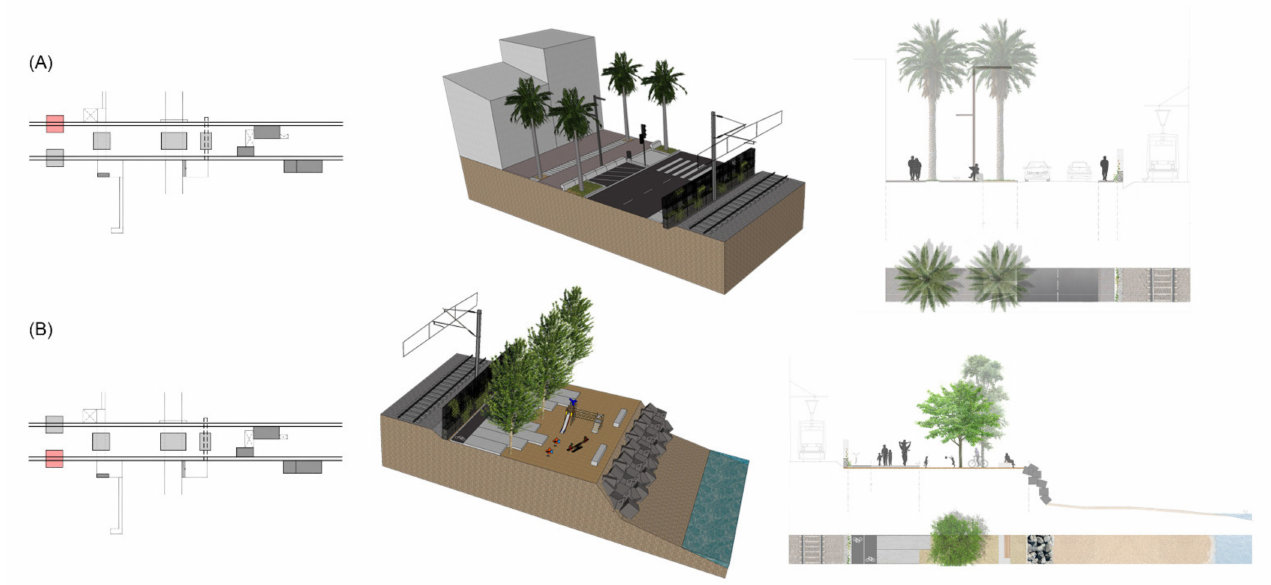
Figure 14. Standardized solutions for longitudinal typologies (Source: authors’ own). ( A ) Urban side and civic way. ( B ) Maritime side and greenway.